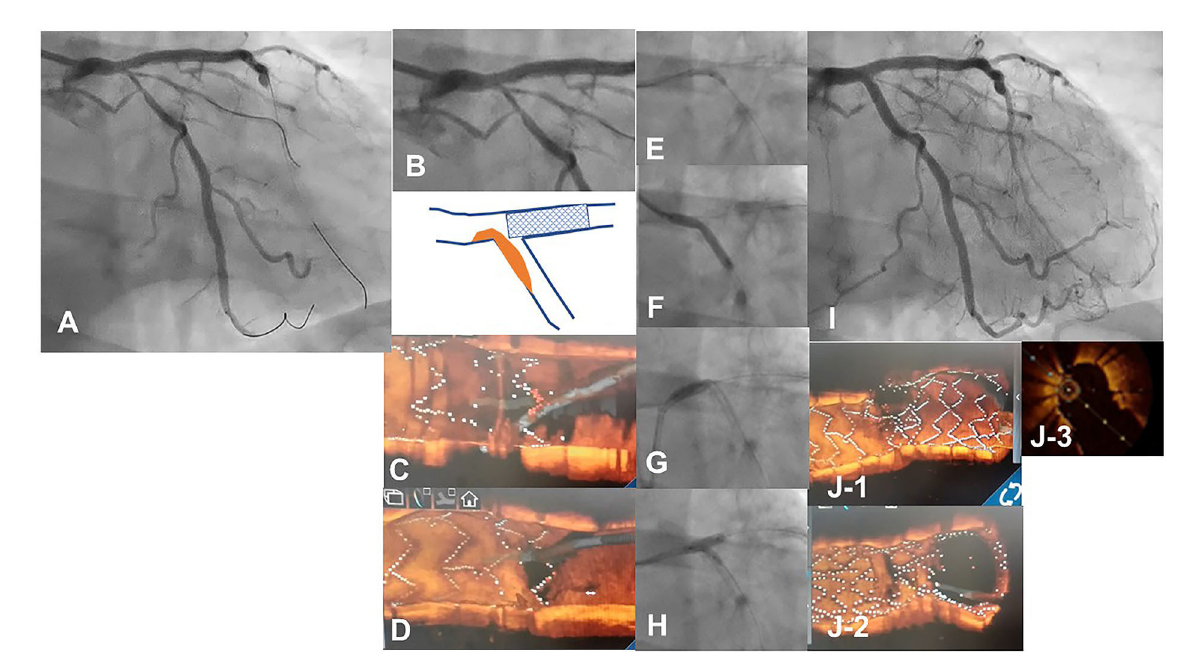
FIGURE6 3D optical coherence tomography (OCT) guided guidewire crossing in a one-string culotte stenting. A 63-year-old man who underwent a 3.5/28mm Xience Alpine stent implantation for chronic total occlusion of the proximal left anterior descending artery (LAD) previously was treated for the progression of stenosis in left main (LM) to the left circumflex artery (LCX) (A) . Medina 1-0-1 lesion in the LM bifurcation (B) was identified (Supplementary Movie 6) and LAD stent was minimally protruded in the LCX ostium ( B bottom scheme). First guidewire crossing to the most proximal cell of the LAD stent failed (C) and second crossing using a double-lumen catheter succeeded (D) (Supplementary Movie 7). After the dilation of the cell to one string using a 2.5mm balloon (E) , a 3.0/26mm resolute integrity stent was deployed from LM to proximal LCX (F) to perform one-string culotte stenting. After proximal optimization using a 4.0mm balloon (G) , guidewire recrossing to the LAD in the optimal cell is confirmed in the 3D OCT imaging and final KBI using 4.0 and 2.5mm balloons is completed (H) . Final coronary angiography shows acceptable results (I) (Supplementary Movie 6), and OCT images show adequate dilation without significant incomplete strut apposition in both branch ostia and one-string metal overlapping in the LM ( J − 1 : pullback from LCX, J-2 : pullback from LAD, J-3 : 2D image of the bifurcation in the pullback from LCX) (Supplementary Movie